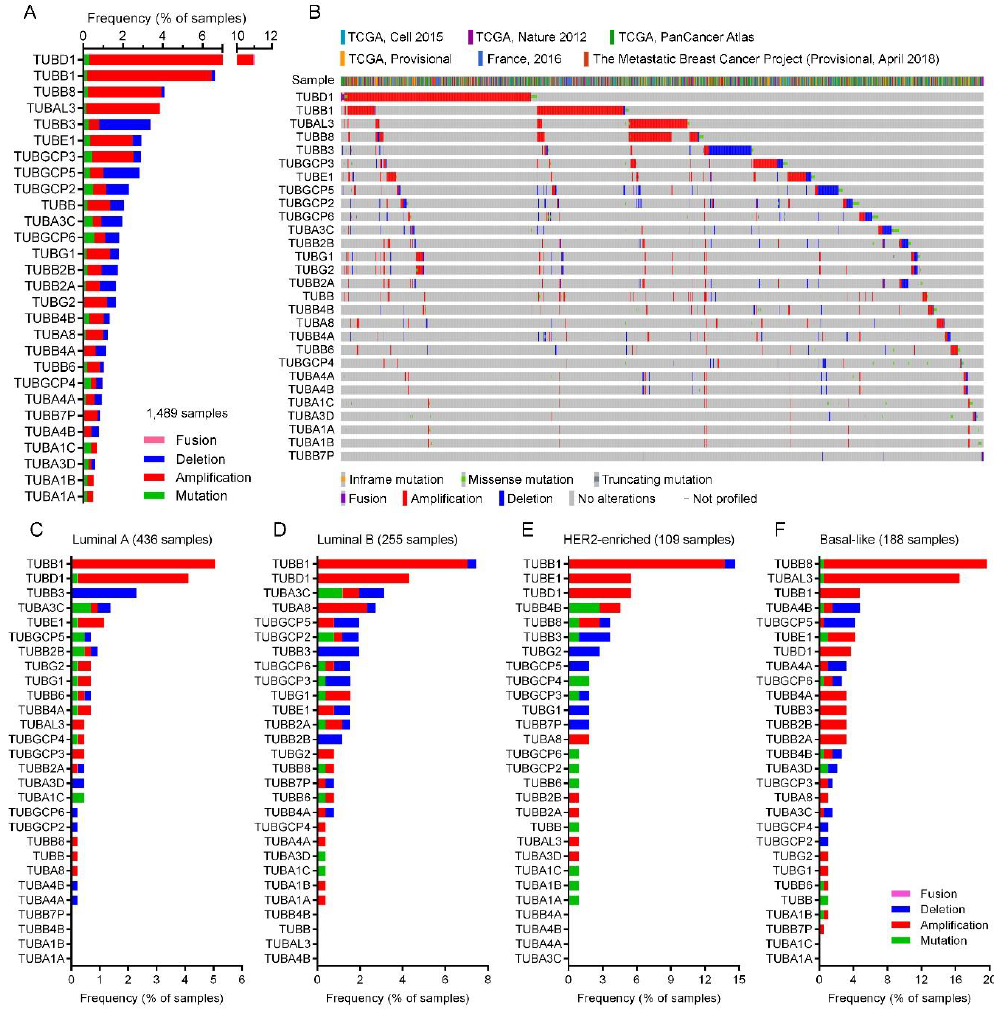
Figure 2. Genetic alteration of tubulin isoforms in meta-study BC tumor samples. ( A ) Frequency of mutation, amplification, deletion and fusion of tubulin isoforms genes. ( B ) Heatmap genetic alteration of tubulin isoforms in each BC tumor samples with at least one alteration. ( C ) Frequency of genetic alteration of tubulin isoforms in the luminal A, ( D ) luminal B, ( E ) HER2-enriched and ( F ) basal-like BC tumors from TCGA, Cell 2015 and TCGA, Nature 2012 studies.